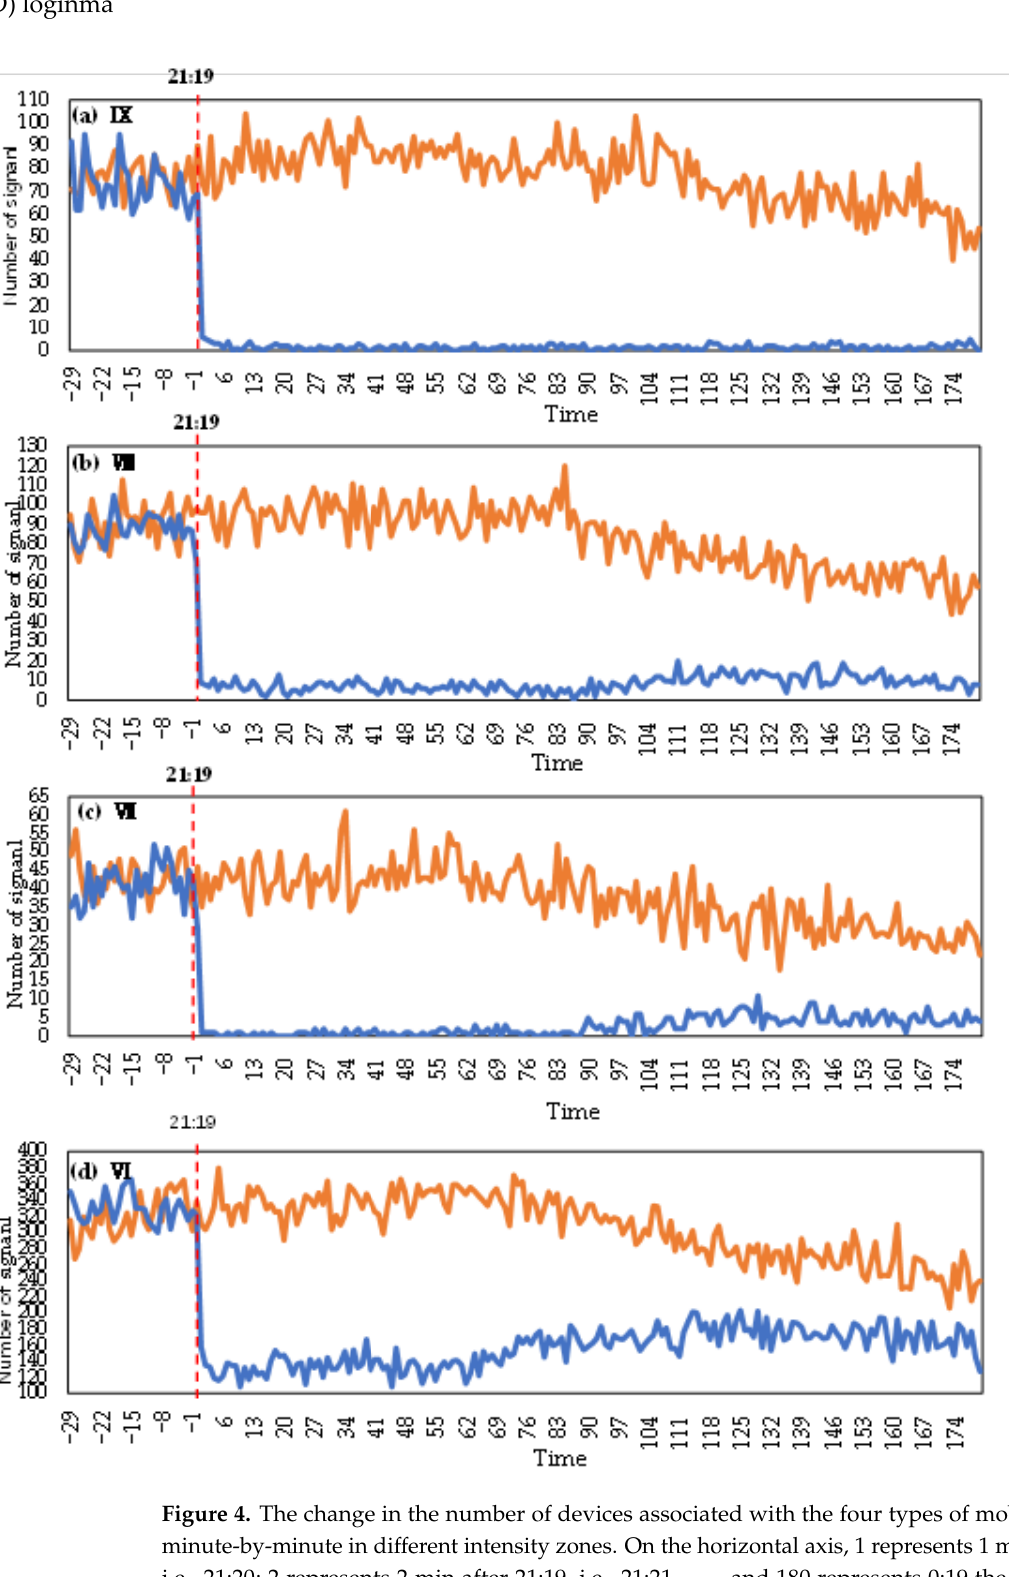
Figure 4. The change in the number of devices associated with the four types of mobile signaling minute-by-minute in different intensity zones. On the horizontal axis, 1 represents 1 min after 21:19, i.e., 21:20; 2 represents 2 min after 21:19, i.e., 21:21, . . . , and 180 represents 0:19 the next day. − 1 represents 1 min before 21:19, i.e., 21:18, 2 represents 2 min before 21:19, i.e., 21:17, . . . , and − 29 represents